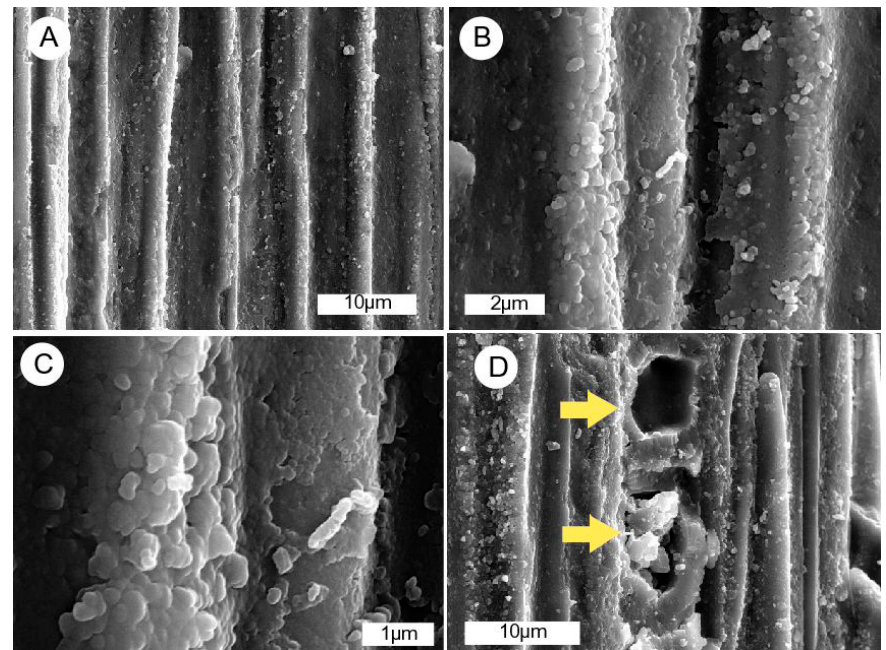
Figure 14. SEM images. ( A, B ) Longitudinal view showing silicified cells. ( C ) Chalcedony, showing relict opal lepispheres. ( D ) Tangential view, showing ray cells that are partially open (upper arrow), but with some cells containing crystalline silica (lower arrow) that precipitated during a later mineralization episode.